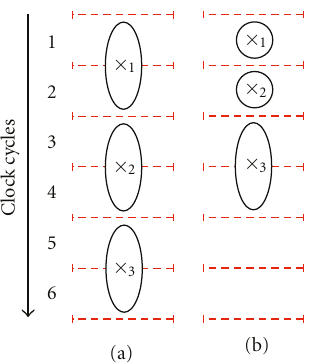
Figure 4: Resource-constrained syntheses: (a) scheduling assuming operators with fixed delay, (b) scheduling assuming operators with variable delays depending on data